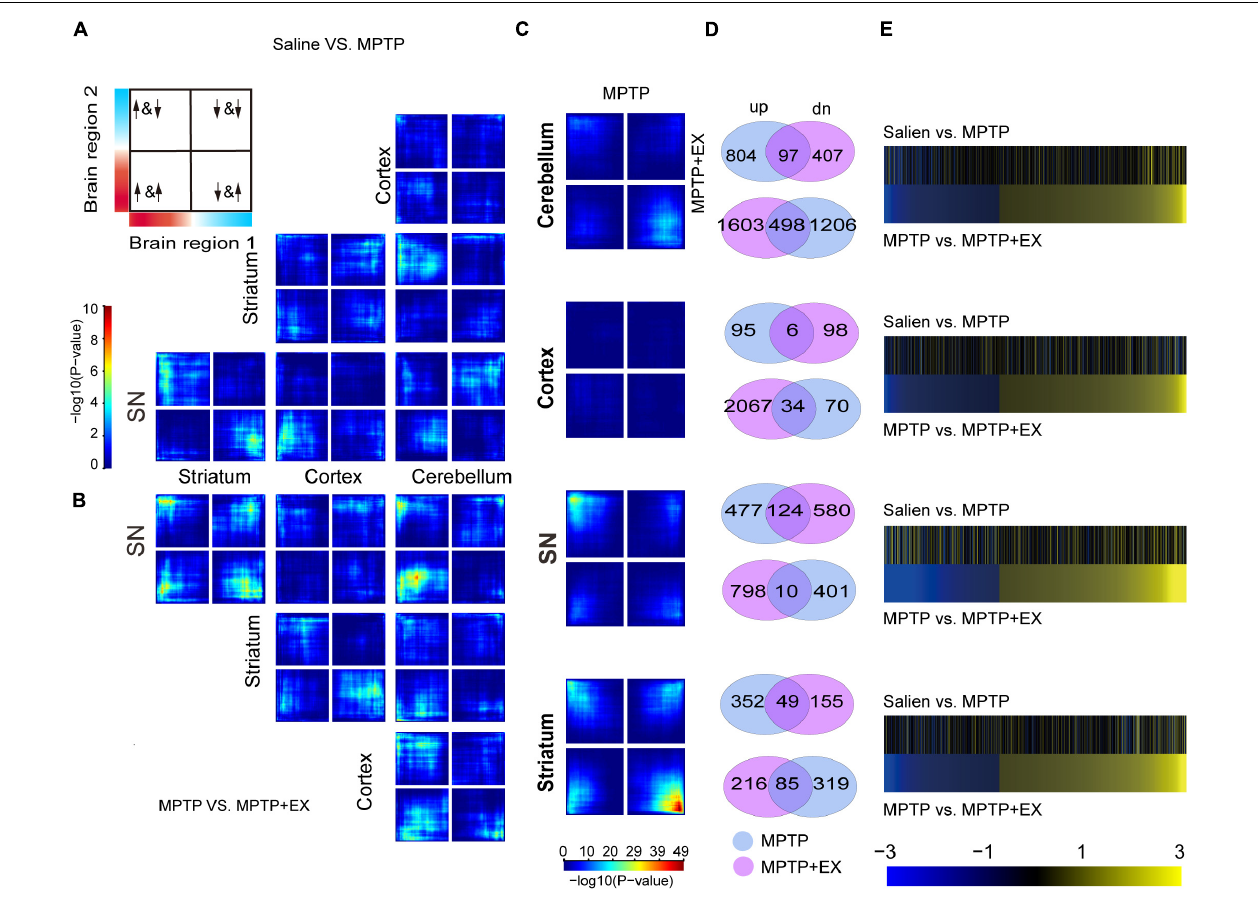
FIGURE 2 | Inter-regional expression patterns reveals PD- and exercise-specific co-upregulation signatures. (A,B) RRHO maps comparing differential expression between 2 brain regions in PD mice [saline vs. MPTP, (A) ] and exercised PD mice [MPTP vs. MPTP + EX, (B) ]. The upper left in Panel A displays the overlap relationship across brain regions, and signals in the bottom left quarter show the genes overlap in common. The color bar spanning in Panel A represents p -values. (C) RRHO maps comparing differential expression between PD (saline vs. MPTP) and exercised PD mice (MPTP vs. MPTP + EX). (D) Venn diagrams display the overlap genes in MPTP and MPTP + EX in 4 brain regions. (E) Heat maps compare transcriptional changes [log(FC)] in PD to exercised PD mice across brain regions. For each brain region, the top pair of heat maps represents directionality of changes in PD mice for genes expressed in PD mice, while the bottom pair of heat maps represents directionality of changes for genes expressed in exercised PD